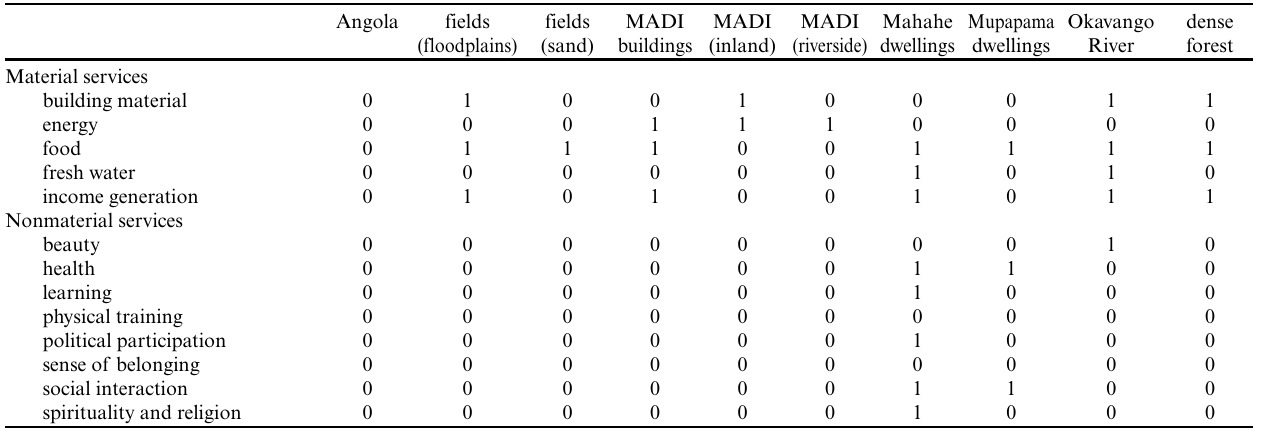
Table 2 . Cultural consensus in which landscape unit services can be